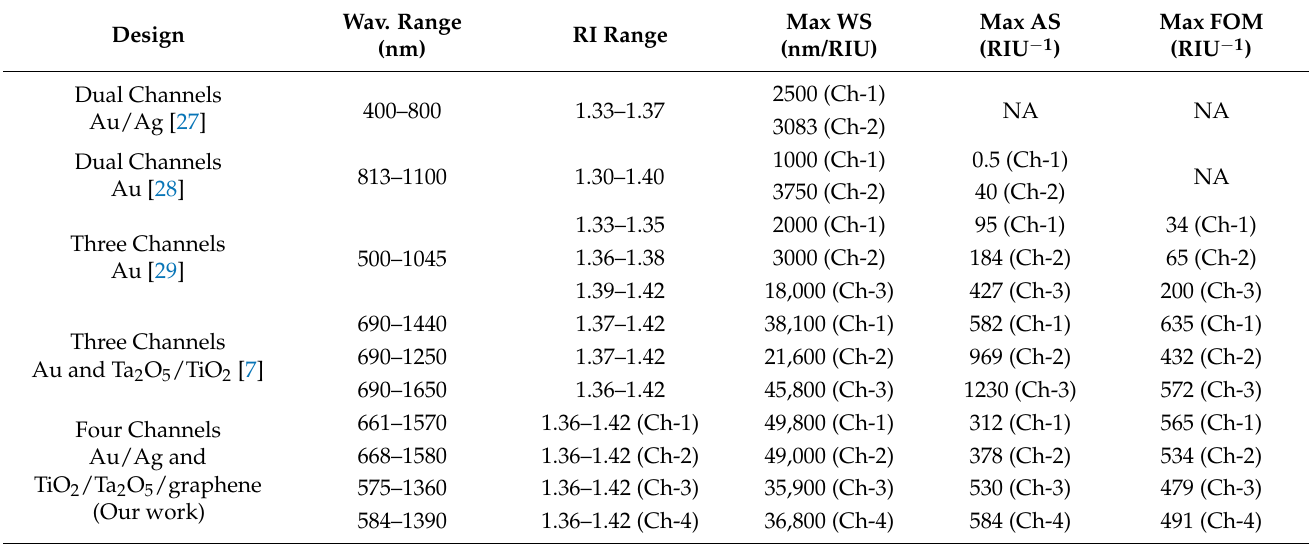
Table 2. Performance comparison of the proposed multi-channel sensor with existing